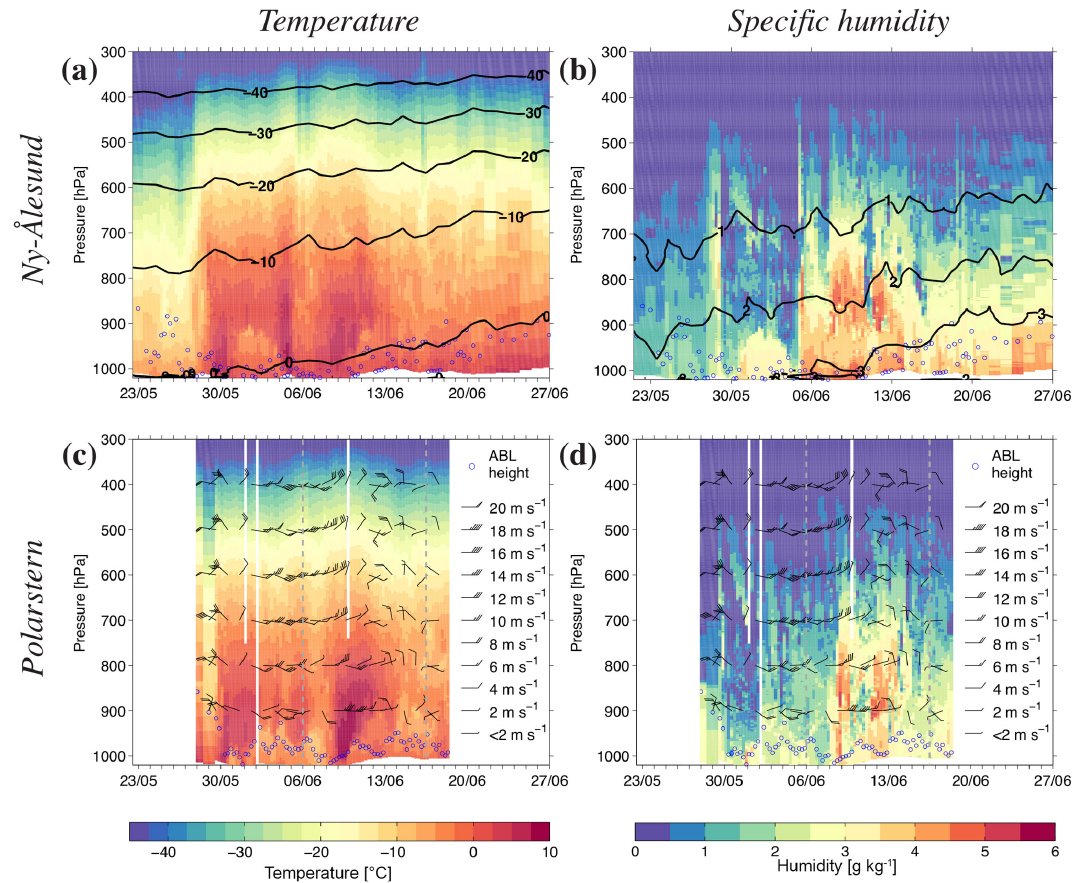
Figure 4. Vertical profiles of (a, c) temperature and (b, d) specific humidity measured at (a, b) Ny-Ålesund and (c, d) Polarstern over the ACLOUD/PASCAL measurement period (23 May–26 June 2017). Blue circles indicate the height of the atmospheric boundary layer (ABL). Black contour lines in (a, b) represent the respective 1993–2016 average, while black arrows in (c, d) represent 2017 values of wind speed and direction. Dashed vertical lines in (c, d) distinguish the Polarstern ocean-crossing periods from the ice-attached period (6–16